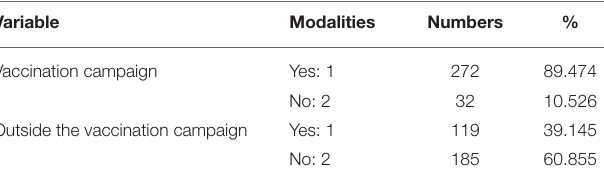
TABLE 2 | Distribution of farmers’ responses on vaccination participation.